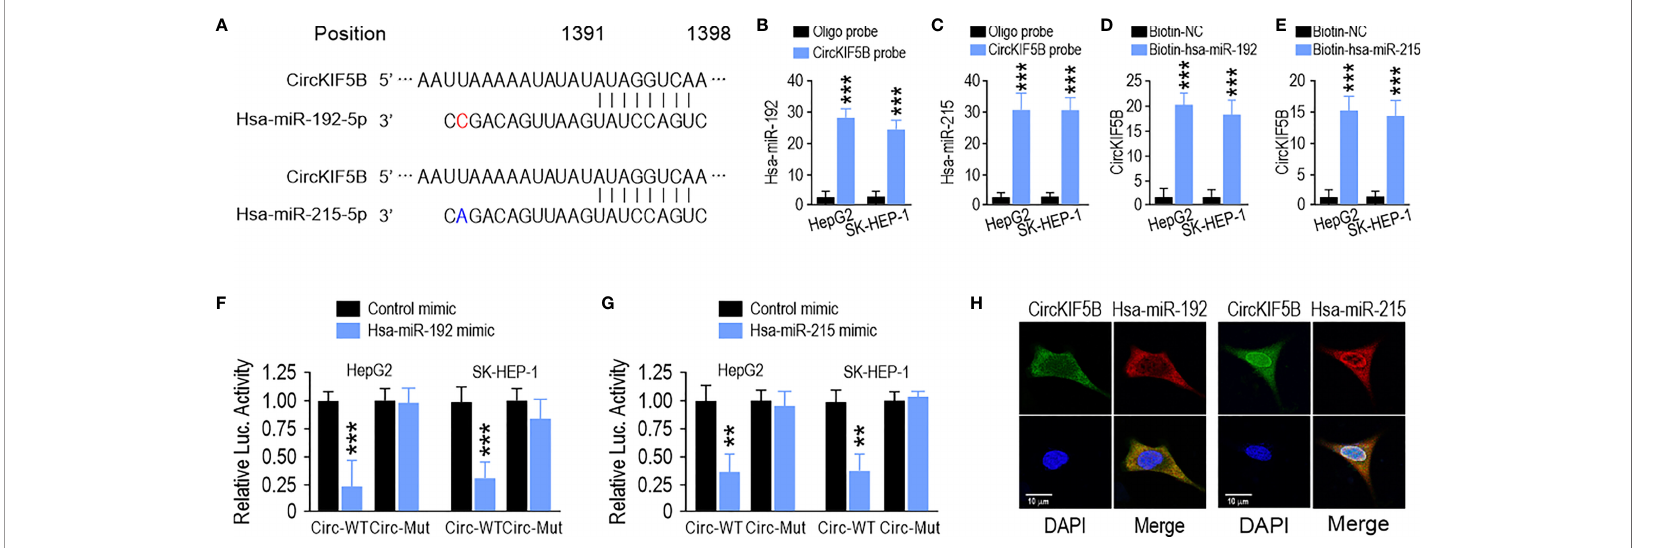
FIGURE 4 | CircKIF5B functions as a sponge for the miR-192 family in HCC cells. (A) The predicted binding sites of miR-192 and miR-215 within the CircKIF5B. (B,C) The relative levels of miR-192 and miR-215 in the HepG2 and SK-HEP-1 cell lysates were detected by qRT-PCR. miR-192 and miR-215 were pulled down by circKIF5B probe in HepG2 and SK-HEP-1 cells. (D,E) CircKIF5B levels were quanti fi ed after the capture of a biotinylated miR-192 probe by qRT-PCR in HepG2 and SK-HEP-1 cells. (F,G) Luciferase reporter activity con fi rmed the interaction between miR-192s and circKIF5B. (H) RNA FISH for circKIF5B and miR-192 detection in HepG2 cells. Blue (DAPI) represented nuclei, green represented circKIF5B, and red represented miR-192 or miR-215. *p < 0.05, **p < 0.01, ***P <